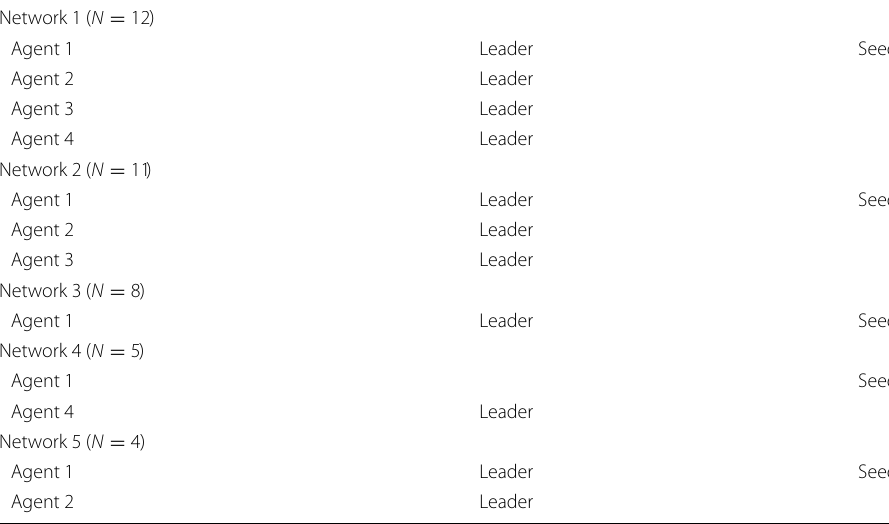
Table of agents who are either network leaders or seeds by